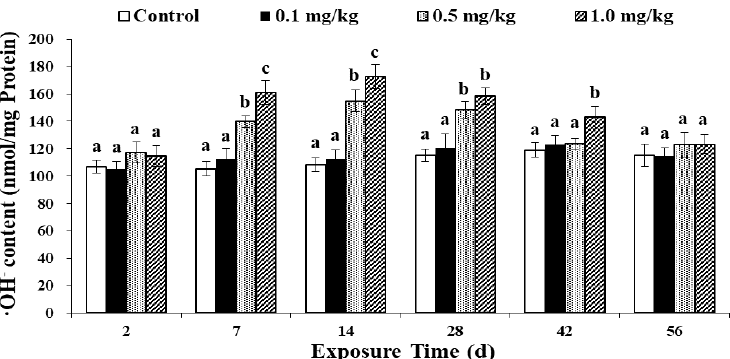
Figure 3. E ff ects of sulfoxaflor on the · OH − content in earthworms. Bars are the means ± SD of five Figure 3. Effects of sulfoxaflor on the  OH − content in earthworms. Bars are the means ± SD of five replicates. replicates. Di ff erent letters indicate significant di ff erences ( p < 0.05) between Different letters indicate significant differences ( p < 0.05) between treatments.